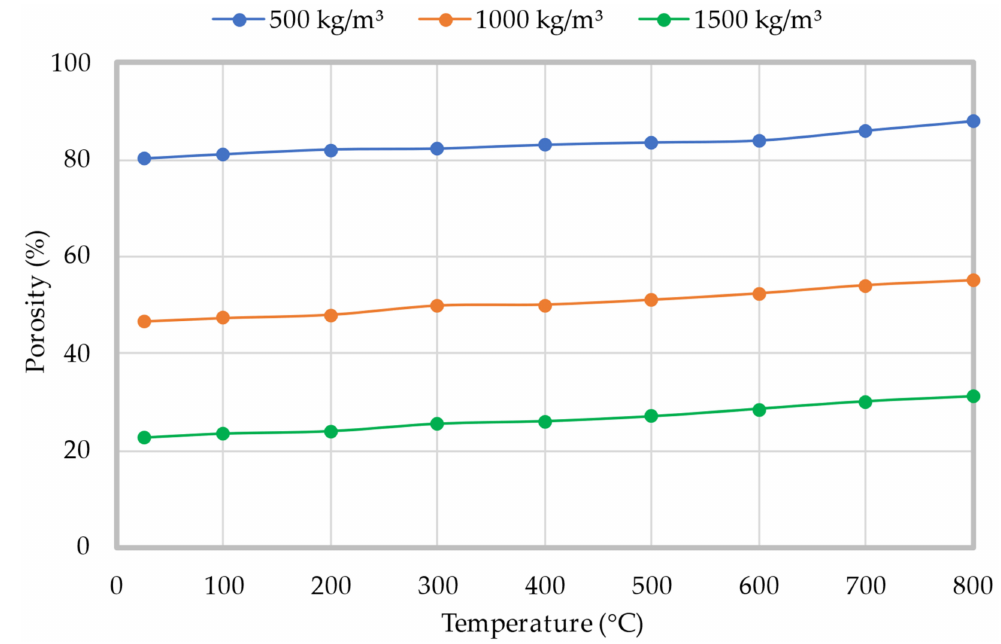
Figure 6. Influence of LFC density on its porosity value at varying